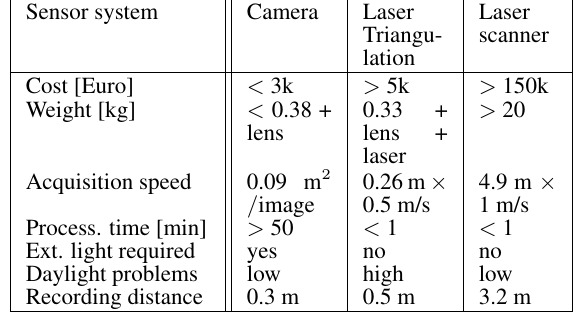
Table 2. Comparison of the used system performances for 0.2 mm cracks on the 70 cm × 70 cm test plate.